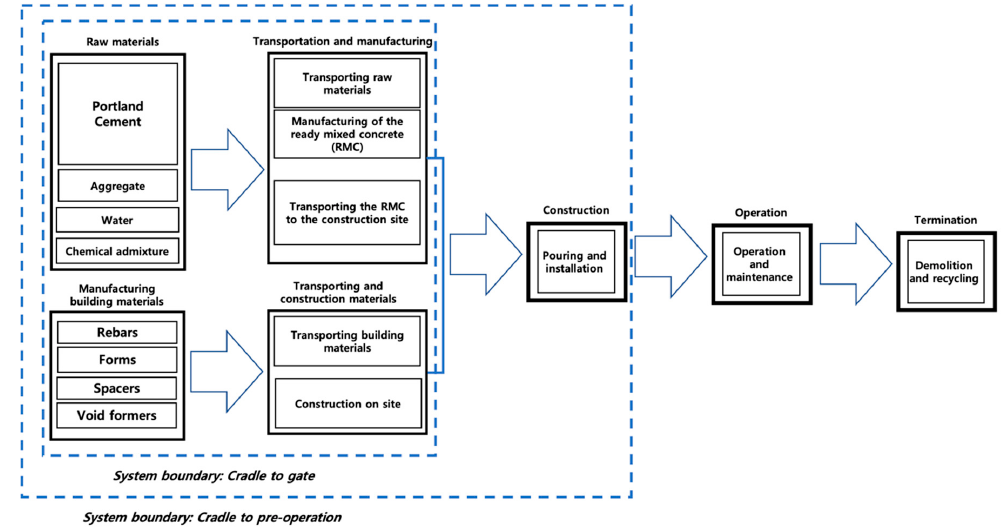
Figure 2. System boundary for the construction process.